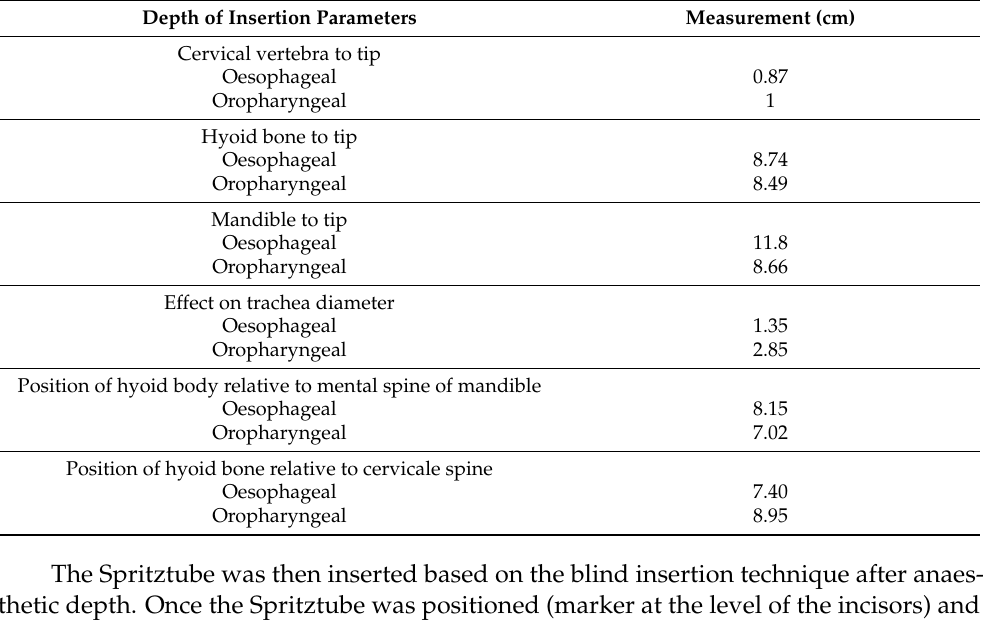
Table 1. Effect on adjacent soft tissue after device insertion and with cuffs inflated.